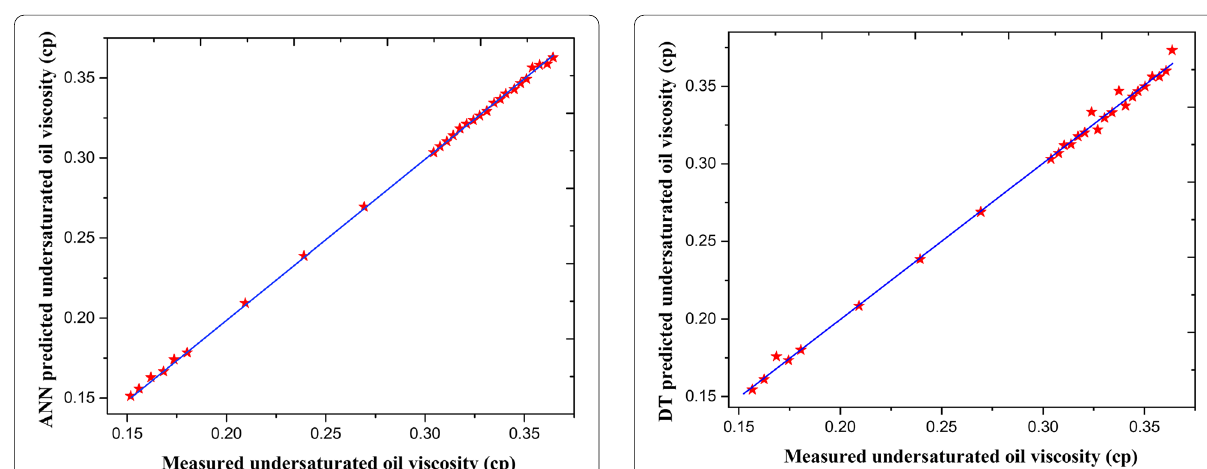
Fig. 8 Cross plot of DT predicted values versus measured values